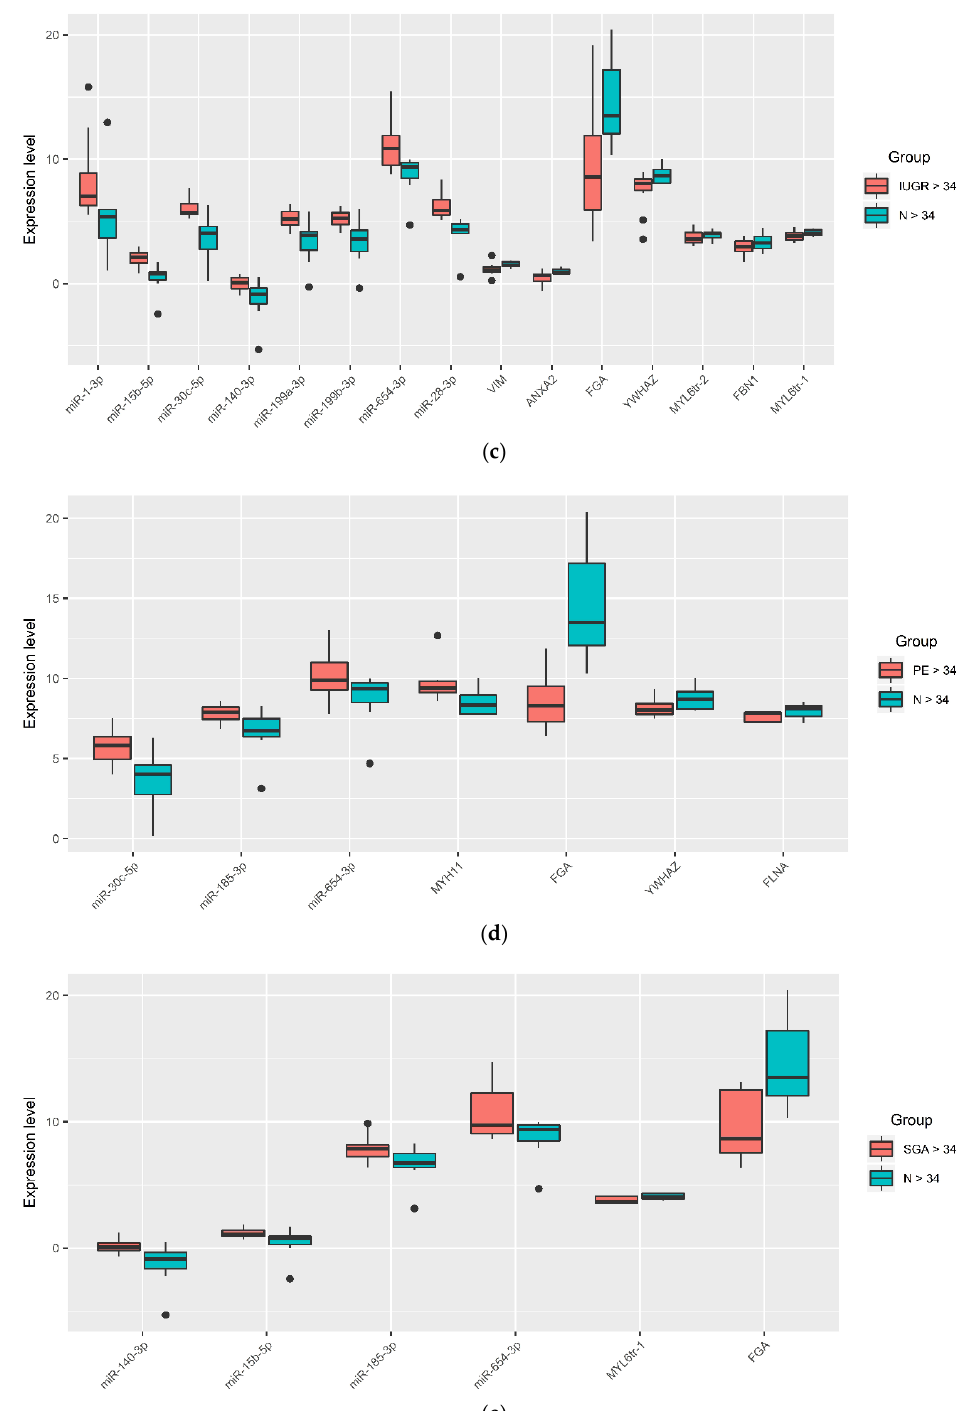
Figure 3. Box-plots of the expression level of miRNAs and their target genes in the placental bed samples by quantitative RT-PCR. Comparison of ∆Ct values of miRNA and mRNA in groups with IUGR < 34 vs. IUGR > 34 ( a ); PE < 34 vs. PE > 34 ( b ); IUGR > 34 vs. N > 34 ( c ); PE > 34 vs. N > 34 ( d ); SGA > 34 vs. N > 34 ( e ).